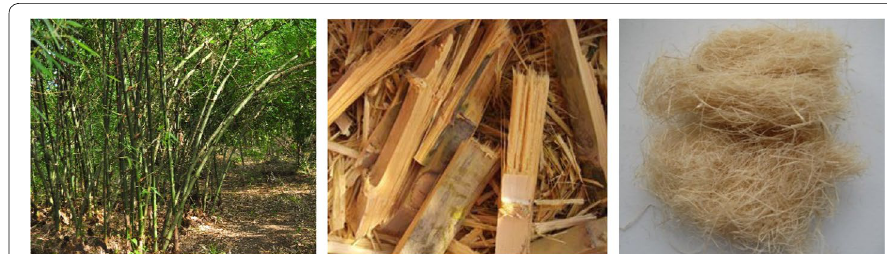
Fig. 1 View of bamboo fiber (native origin and advanced